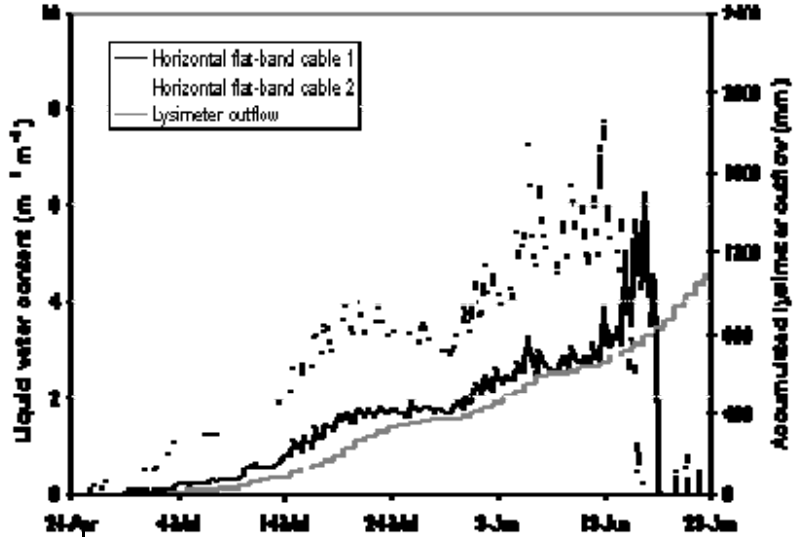
Figure 13. Measurements of LWC in a snowpack as a function of time. Comparison of two TAUPE cables with lysimeter